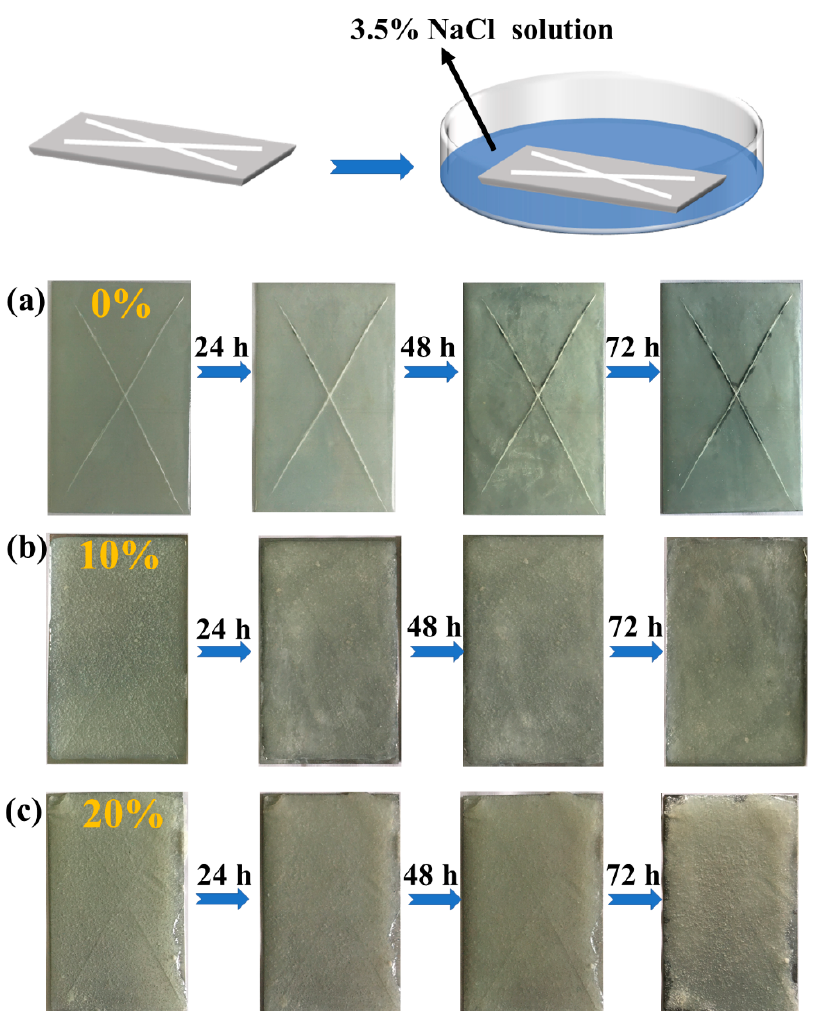
Figure 8. Corrosion of three groups of coatings with different microcapsule content after soaking in NaCl solution. ( a ) 0 wt% MC3, ( b ) 10 wt% MC3 and ( c ) 20 wt% MC3.